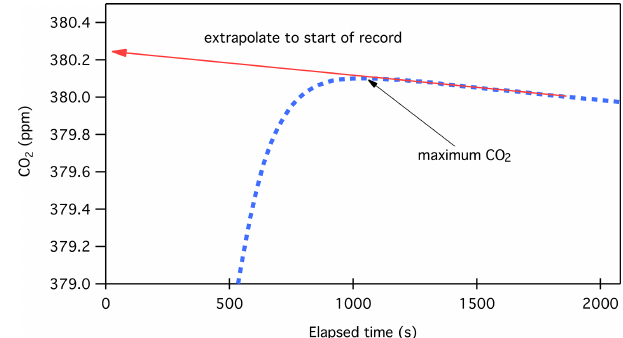
Figure 5. Typical manometer results showing CO 2 calculated as a function of time as the purified CO 2 warms while contained in the small volume. The loss rate is calculated from a linear fit as shown.